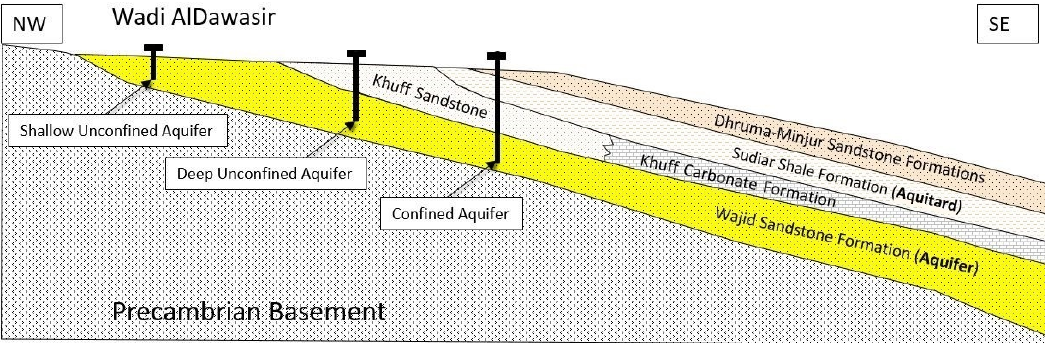
Figure 3. Hydrogeological cross-section of Wajid aquifer showing the hydrostratigraphic units.